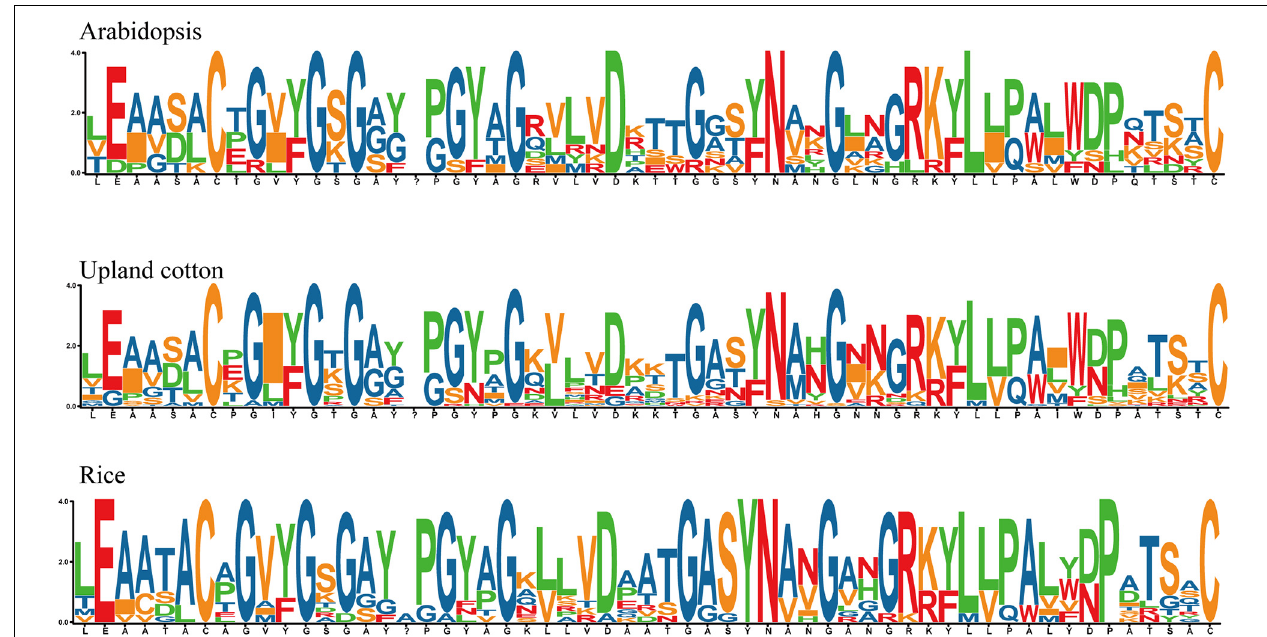
FIGURE 2 | Sequence logo analysis of conserved amino acid residues in predicted EXO proteins. Sequence logos of conserved amino acid residues in the three plant species Arabidopsis thaliana , Upland cotton ( G. hirsutum ), and rice ( O. sativa ) showed highly conserved amino acids in EXO proteins during the evolution of dicot and monocot